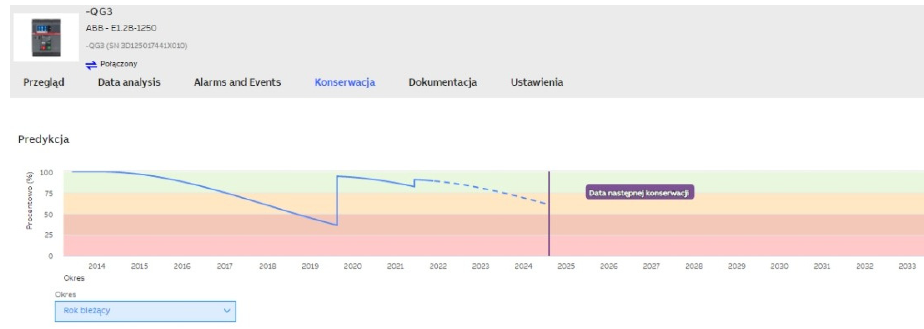
Figure 12. Equipment maintenance prediction.